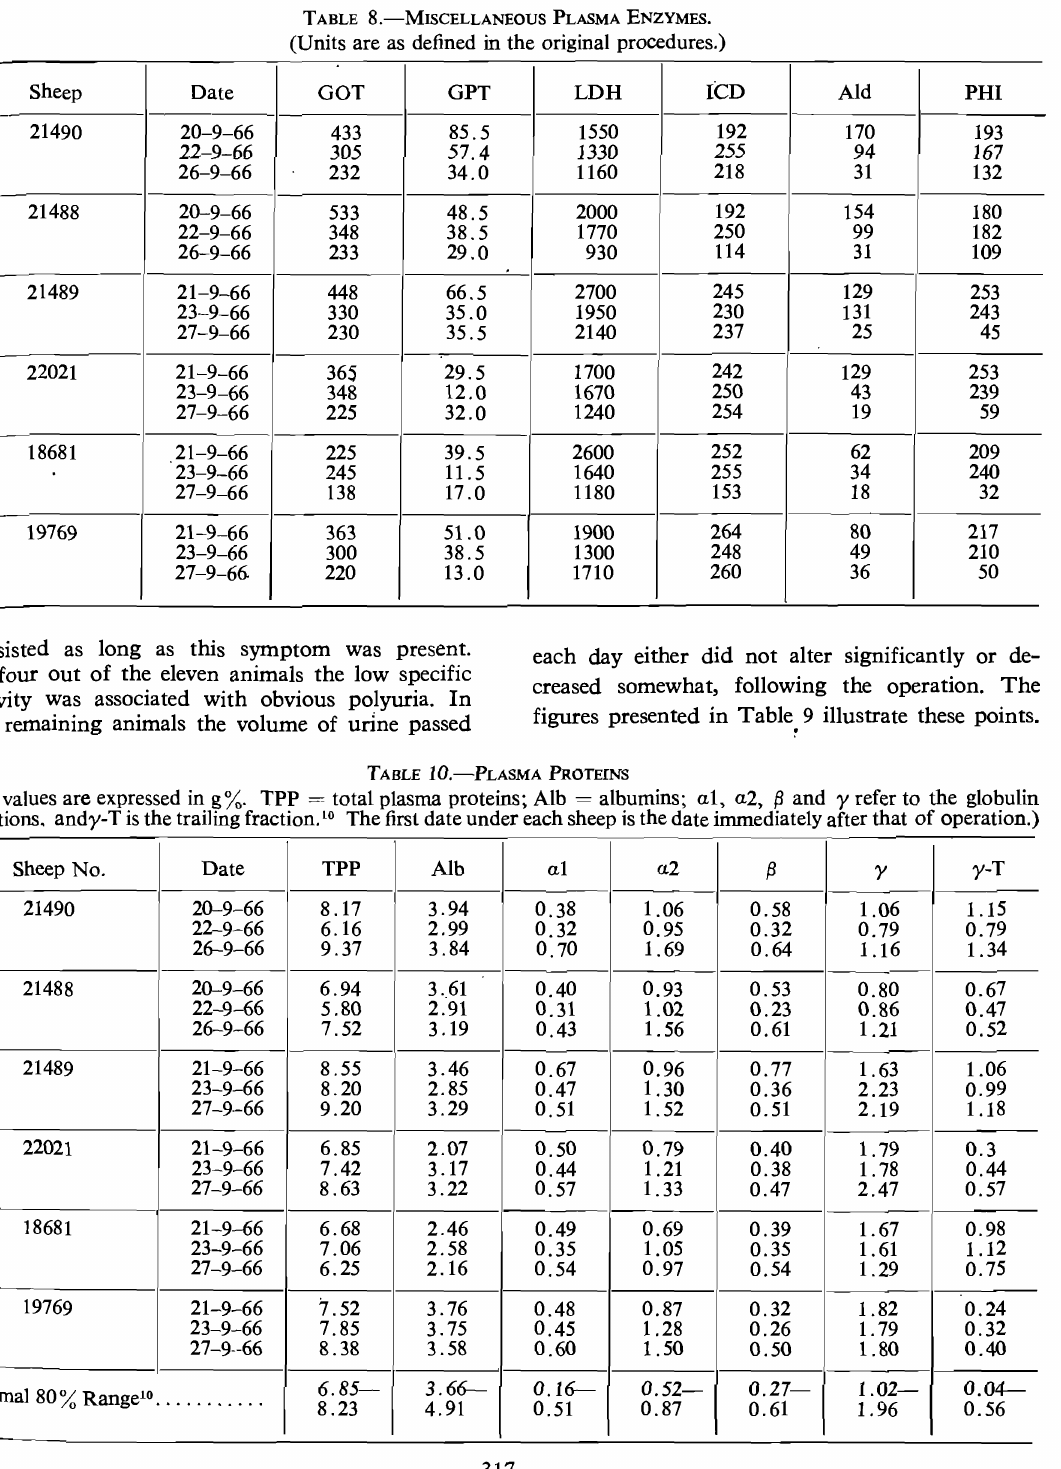
TABLE 8.-MISCELLANEOUS PLASMA ENZYMES. (Units are as defined in the original procedures.)